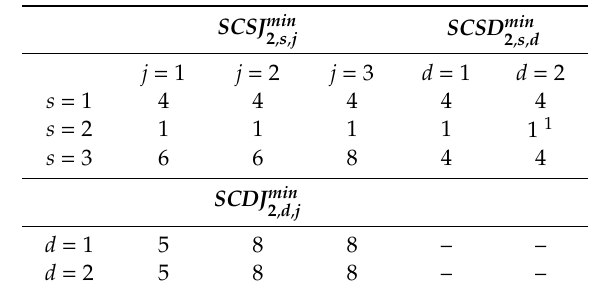
Table A20. Minimum loading capacity per shipment of product 2 (units).